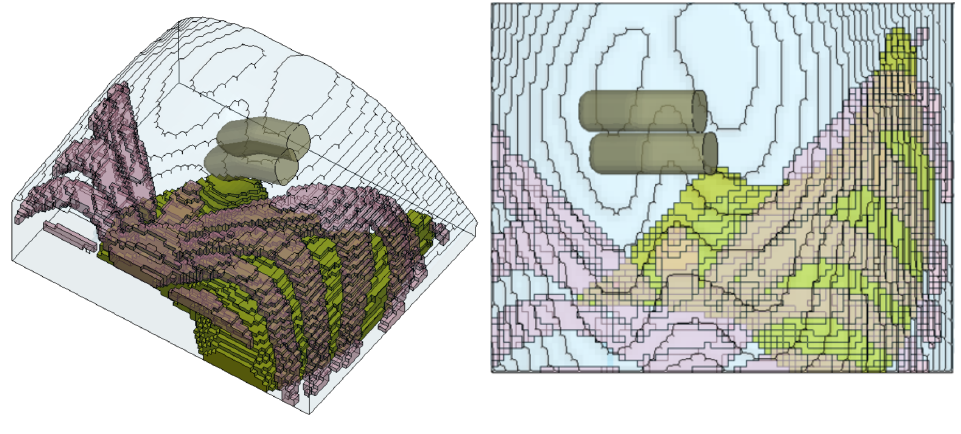
Figure 3. Simulation setup in LS Prepost. ( a ) Reduced version of the simplified abdomen model for simulations. ( b ) Top view of the abdomen model, focusing on the liver organ.